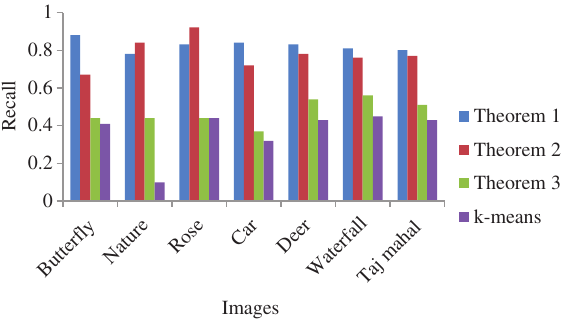
Figure 9: Performance Analysis of Different Approaches Using Recall Measure.